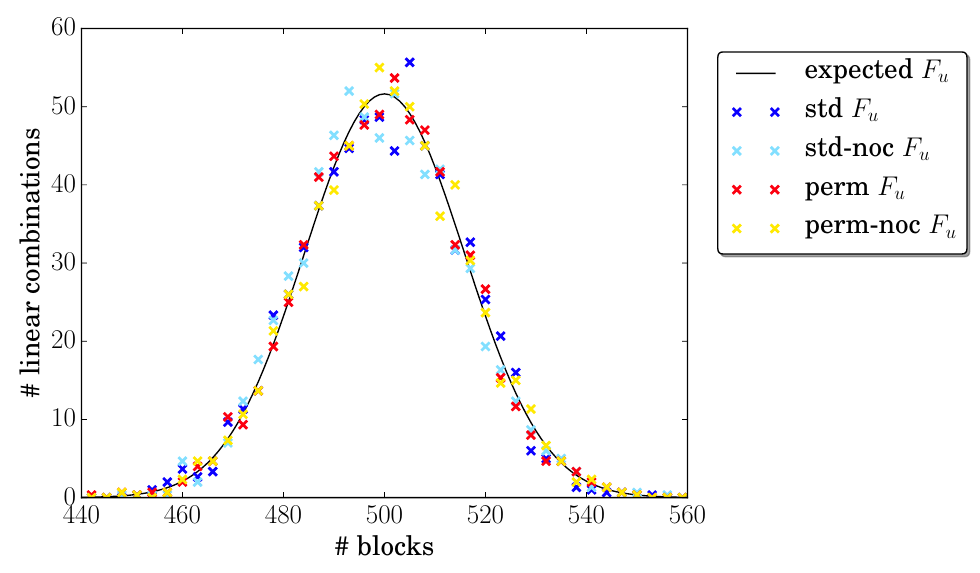
Figure 7: Distribution F u ( x ) for | B | = 1000 and monomial k 1 k 0 for 2 rounds, grouped by